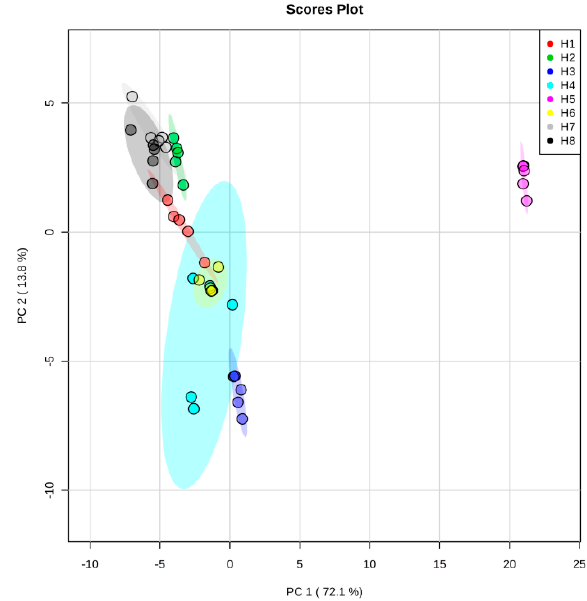
Figure 3. Principal component analysis (PCA) score plot of metabolites identified from Hibiscus calyces using different extraction methods. H1: 1% HCl in methanol, H2: 80% methanol, H3: 100% water, H4: 1% HCl in water, H5: 70% ethanol, H6: 50% methanol, H7: methanol and H8: 1% HCl in 70% ethanol.